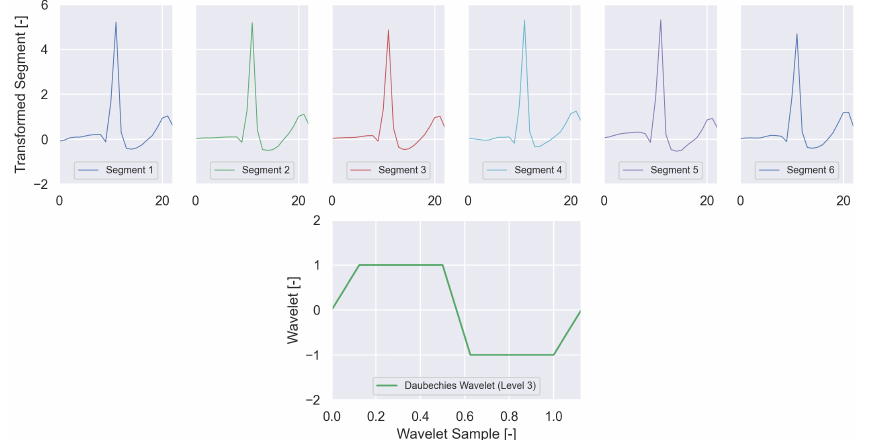
Figure 3. ( Top ) R-peak-centered ECG segments with a +90 and − 90 sample window. ( Bottom ) Wavelet transform applied on the example segments 1–7 and ( bottom ) the Daubechies (db1, level 3) wavelet